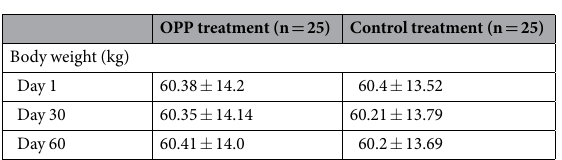
Table 3. Body weight changes in volunteers (mean ± SD).